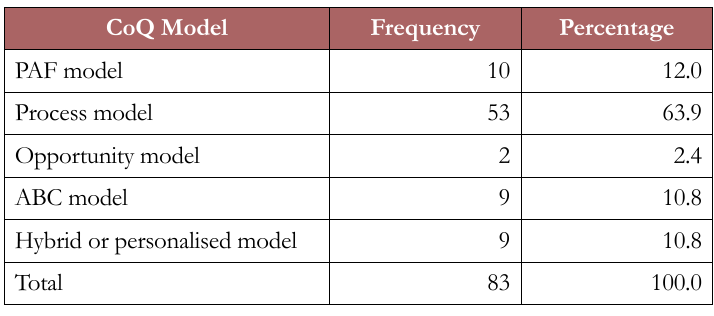
Table 3. Distribution of CoQ